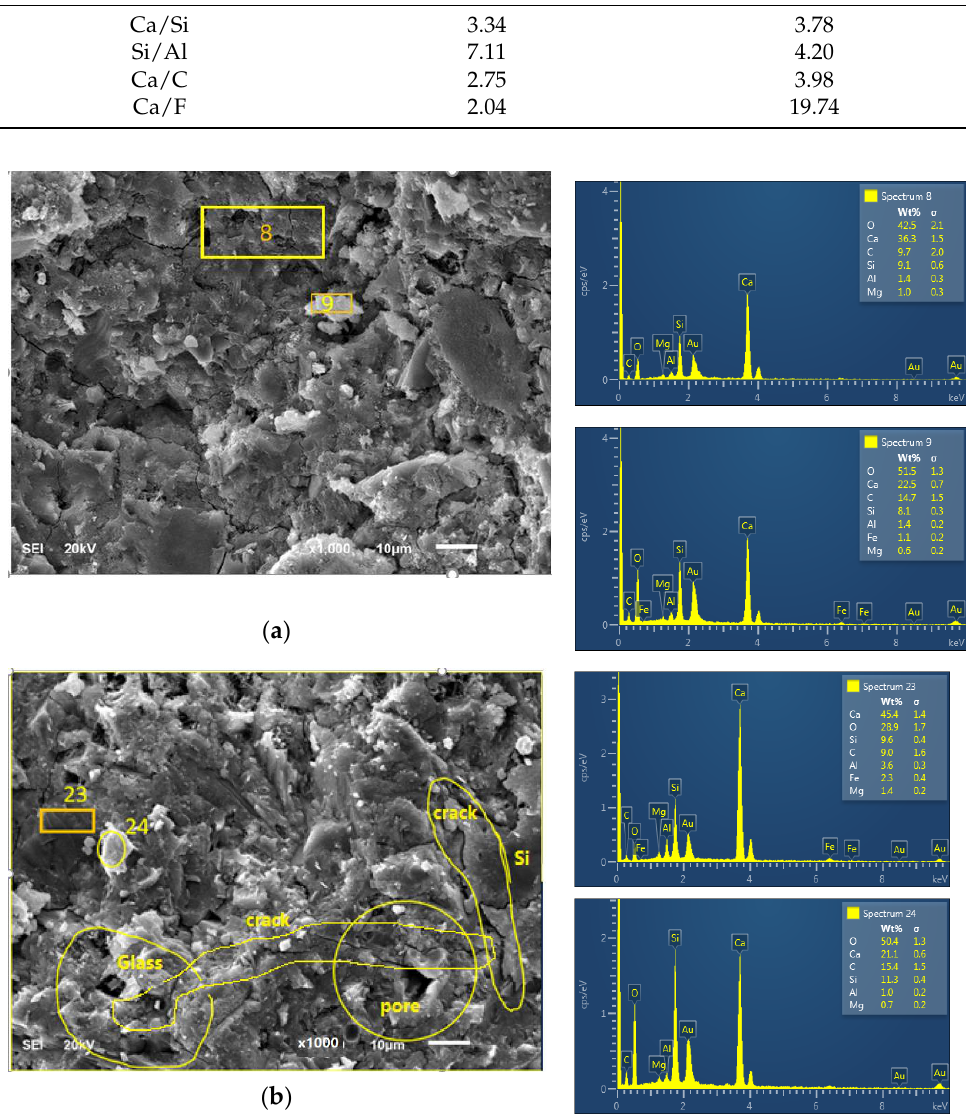
Figure 10. X-ray diffraction spectroscopy of the silica fume and glass/silica-fume binder. ( a ) Silica- fume blended paste ( b ) Glass/silica-fume ternary blended paste